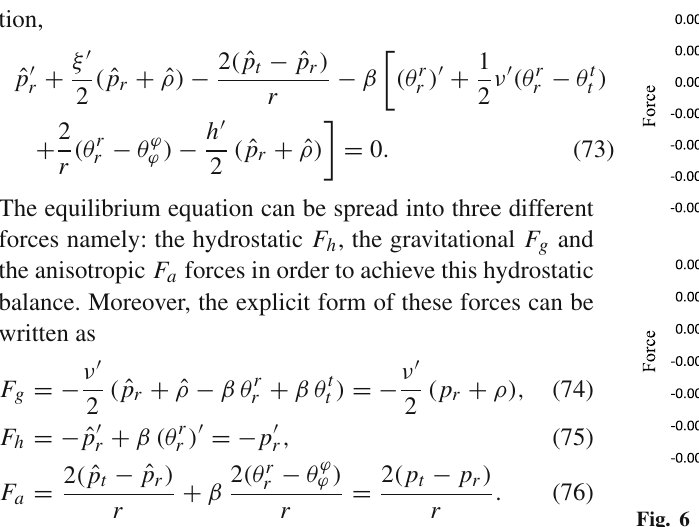
Fig. 5 The trend of the square of radial velocity (v 2 r ) (solidcurves) and tangential velocity (v 2 r ) (dashed curves) versus radial coordinate r / R . The description and numerical values for the free parameters are same as used Fig. 3